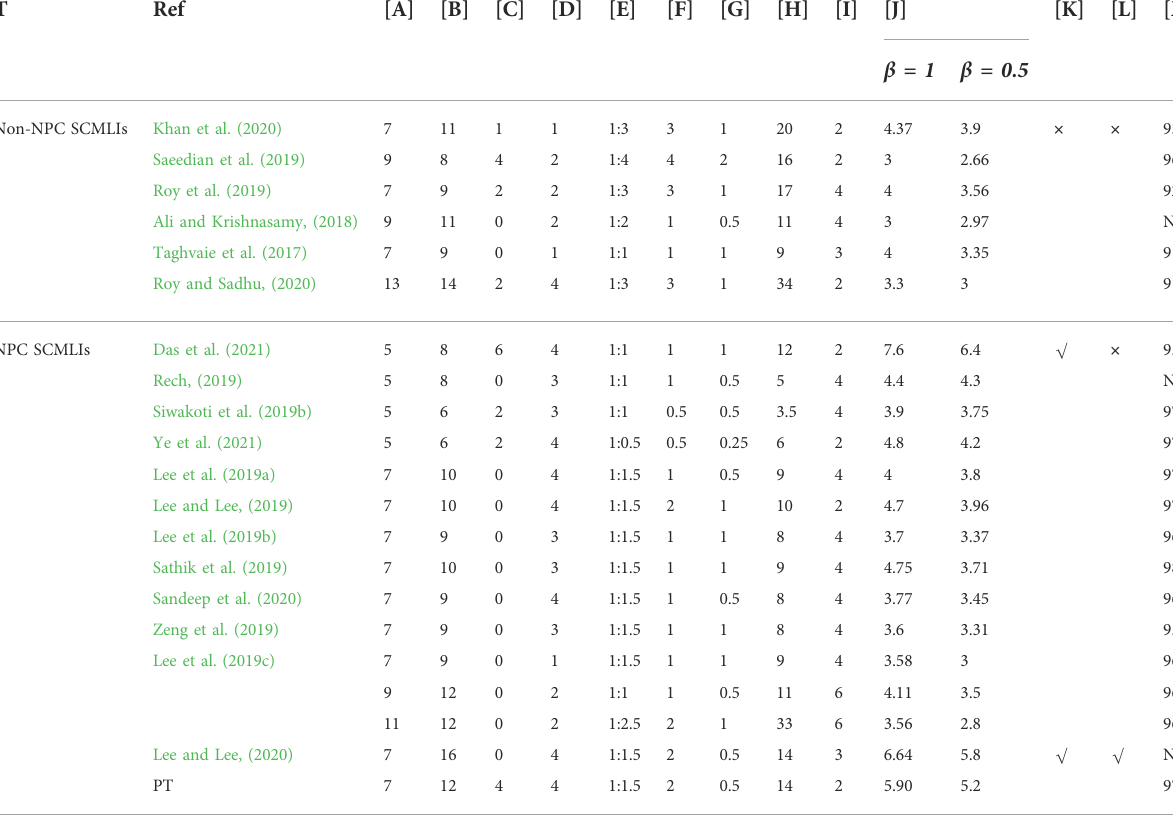
TABLE 2 Performance comparison with existing switched-capacitor-based multilevel